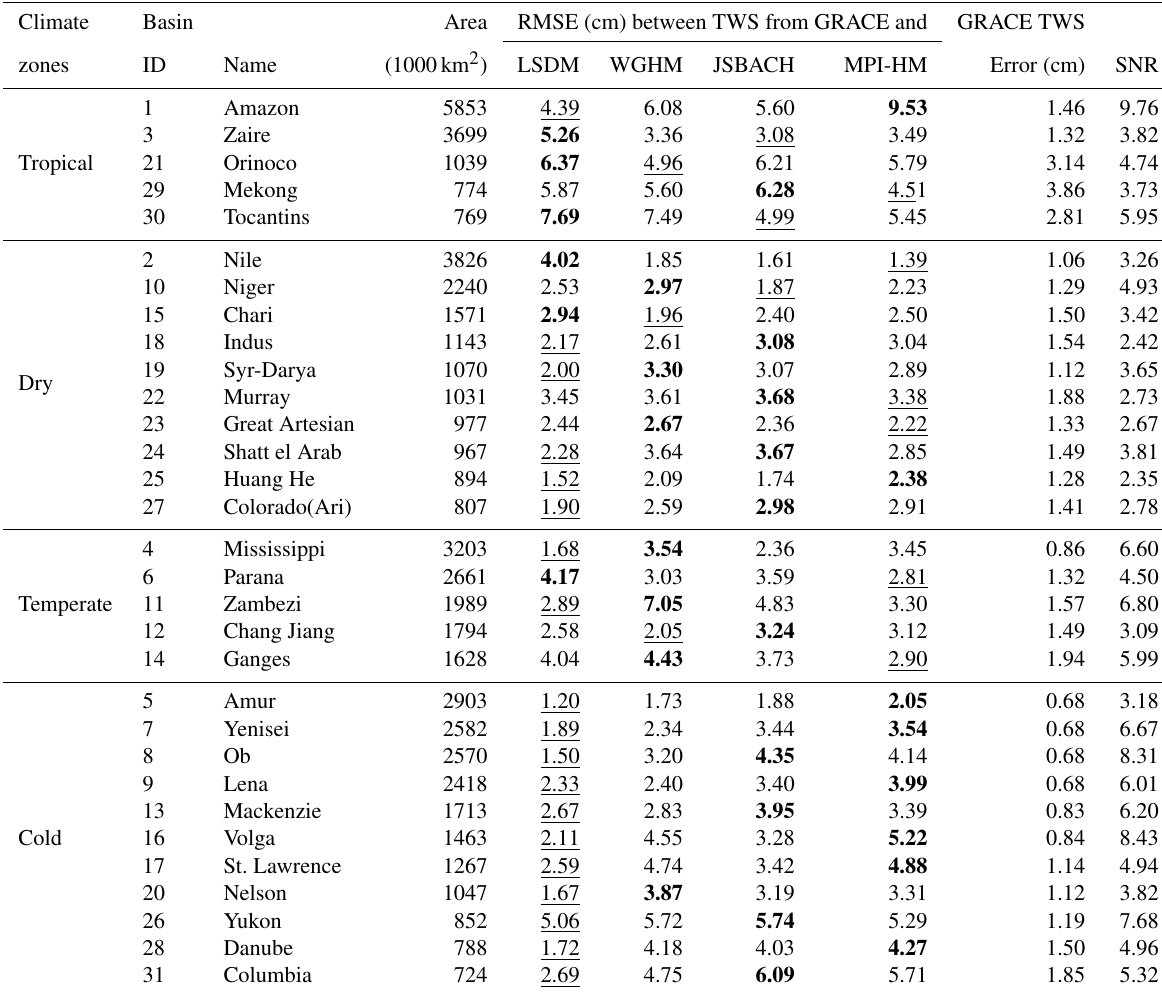
Table 2. Characteristics of the basins shown in Fig. 1. Bold and underlined numbers are the largest and smallest rms differences between GRACE and models